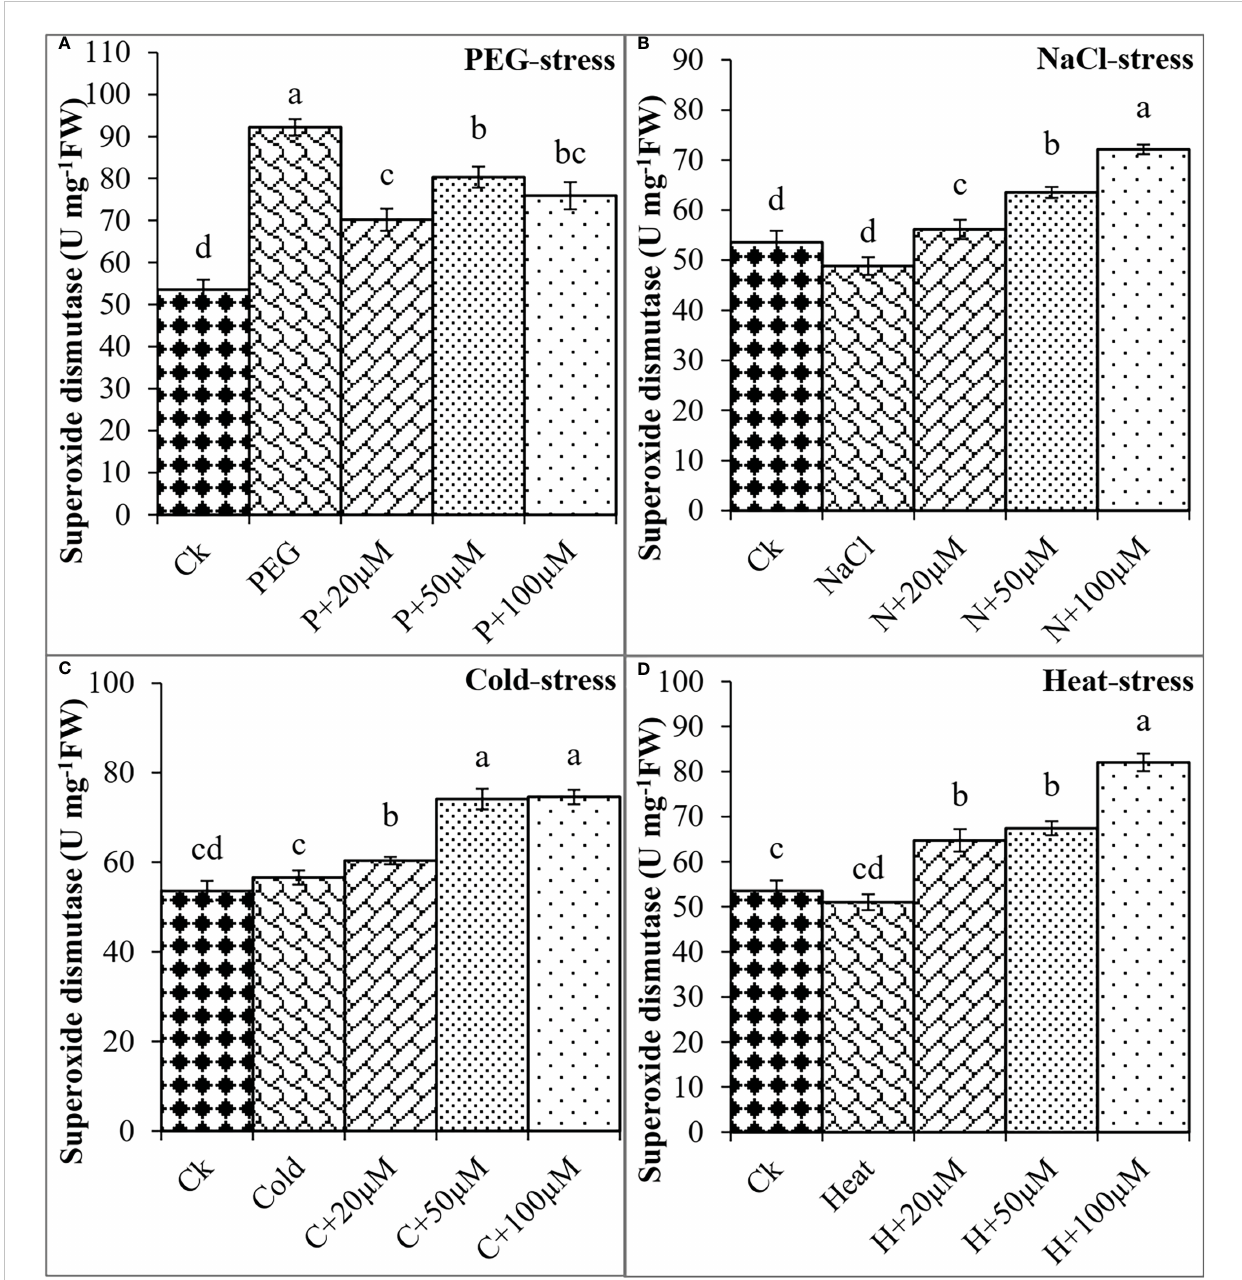
FIGURE 6 Effect of different concentrations of melatonin on the activity of superoxide dismutase under PEG (A) , NaCl (B) , Cold (C) , and Heat (D) . Values are the means ± SD (n=3). Different letters on the bars show a statistical signi fi cance level at p<0.05 . Here, µM is indicating (µmole L -1